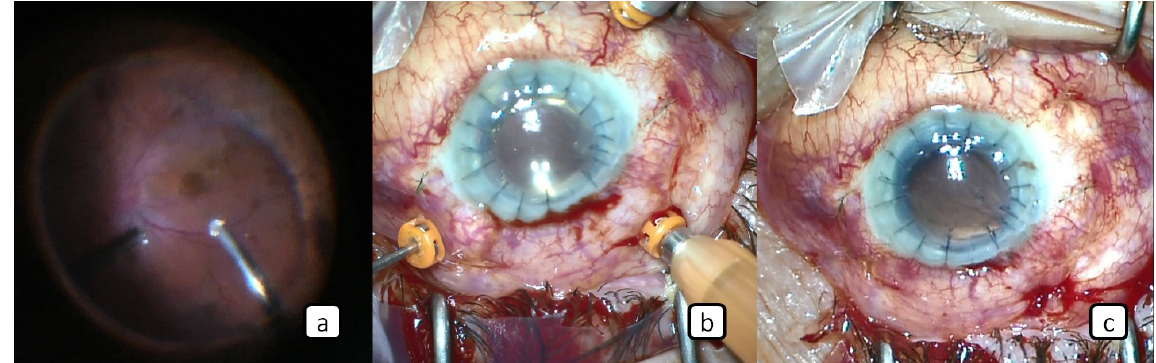
Figure 3: a) The perfluorooactane is removed. b) The silicone oil is given into the vitreous cavity. c) At the end of the surgery. pushed back and fixed into the scleral tunnels.